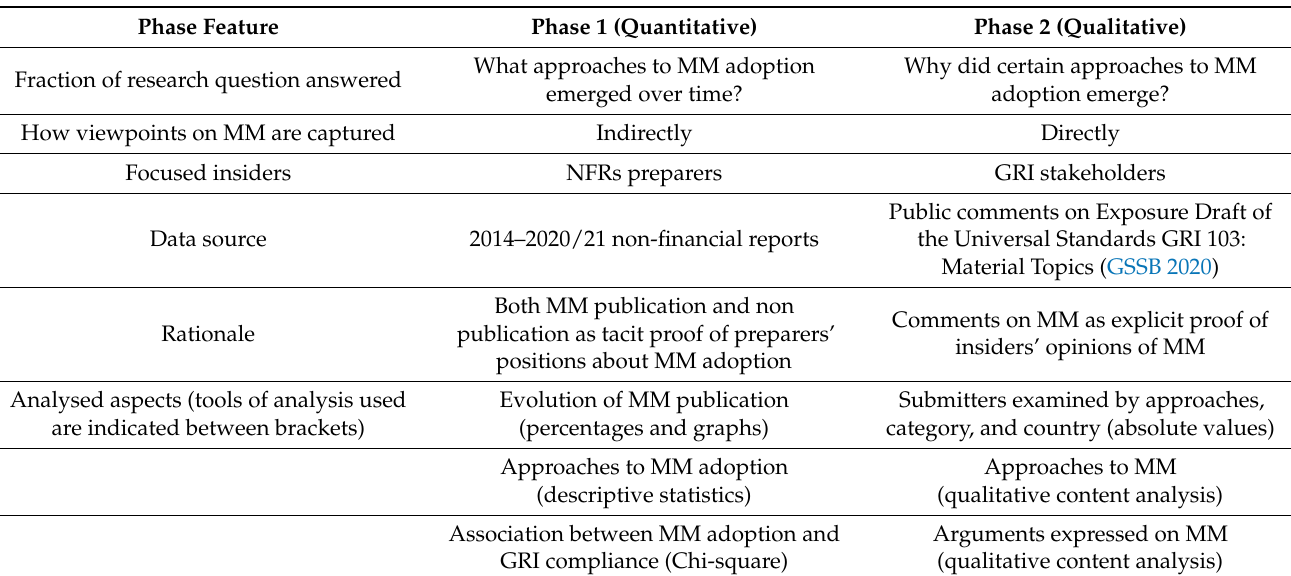
Table 2. Research